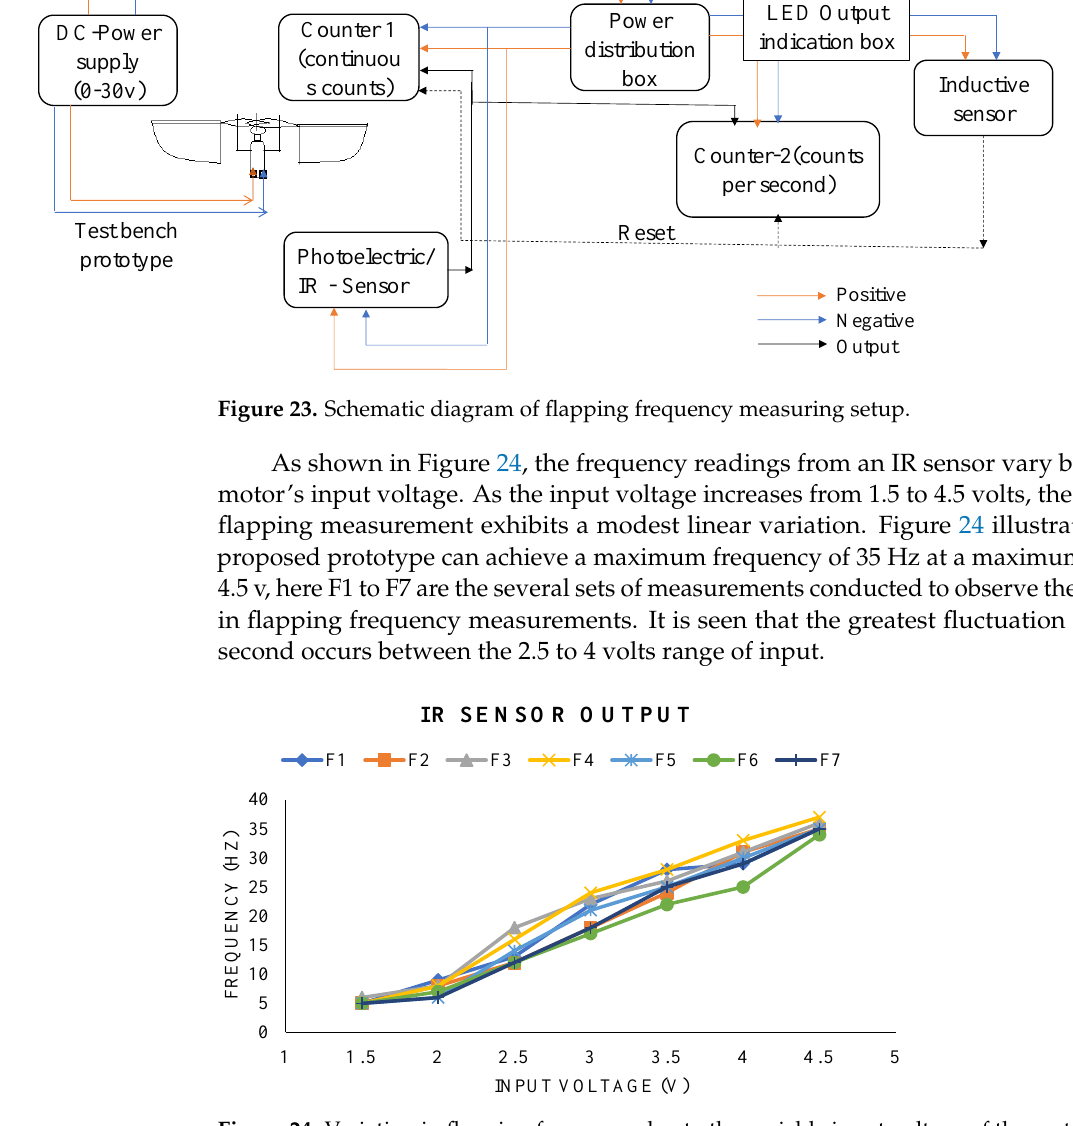
The CRO channels are connected to both sensors, as well as a 24 v DC input source